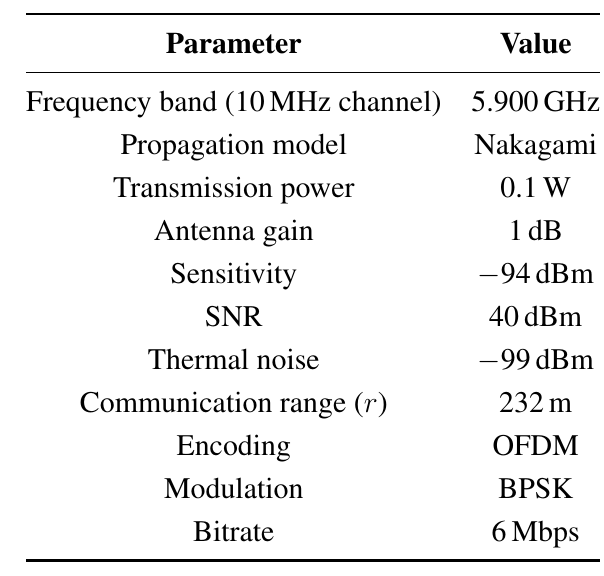
Table 1. Network parameters in the